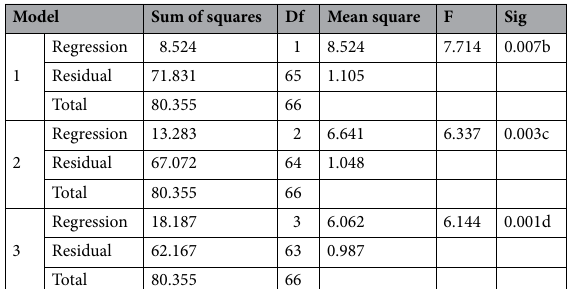
Regression 18.187